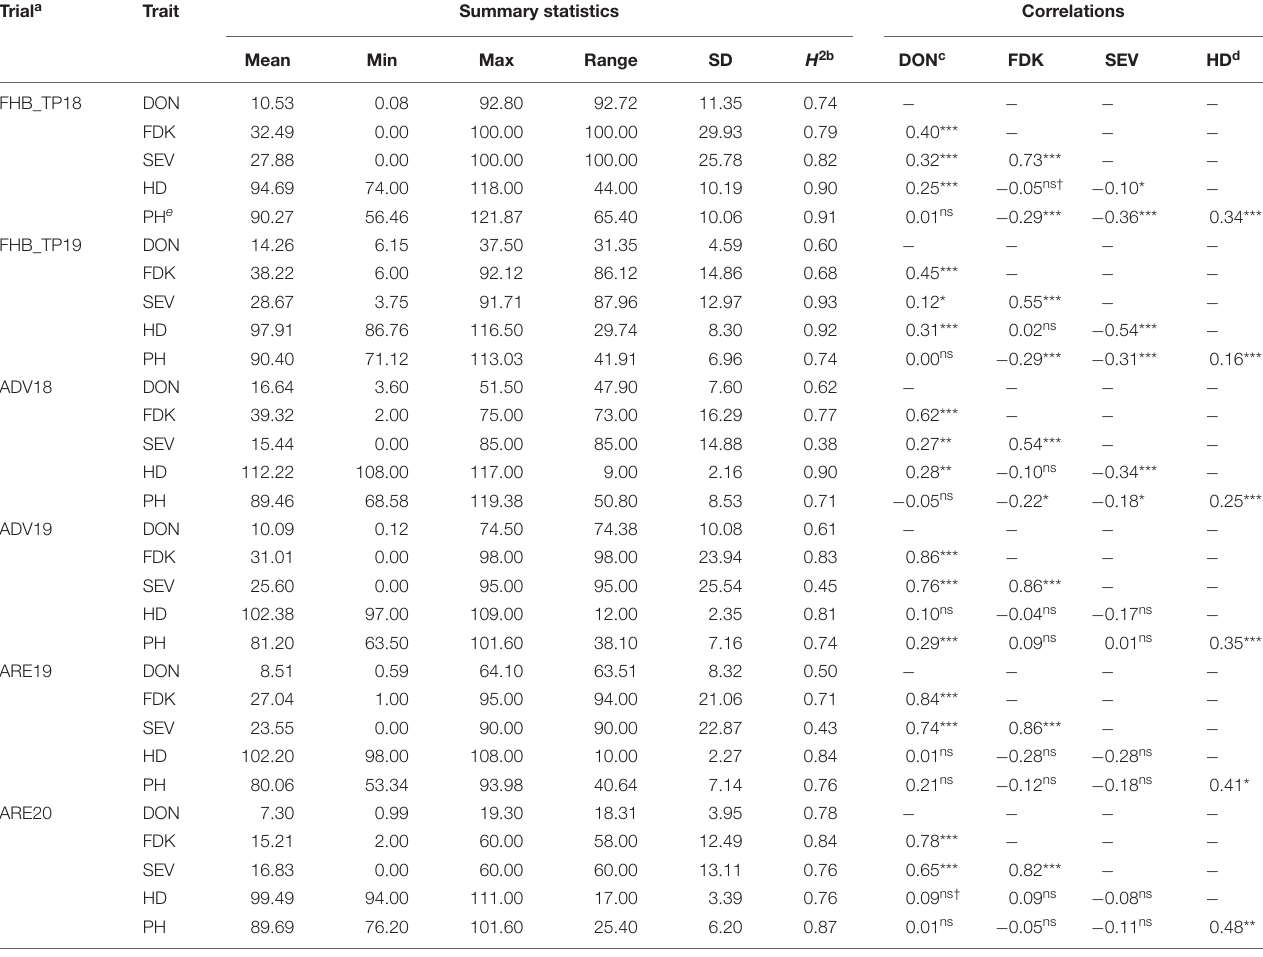
TABLE 2 | Descriptive statistics, Pearson phenotypic correlations, and heritabilities ( H 2 ) for adjusted means for two training populations, two advanced F 4 : 7 nurseries, and two elite F 4 : 8 nurseries for three Fusarium head blight (FHB) resistance traits, including deoxynivalenol (DON), Fusarium damaged kernels (FDK), and severity (SEV) as well as heading date (HD) and plant height